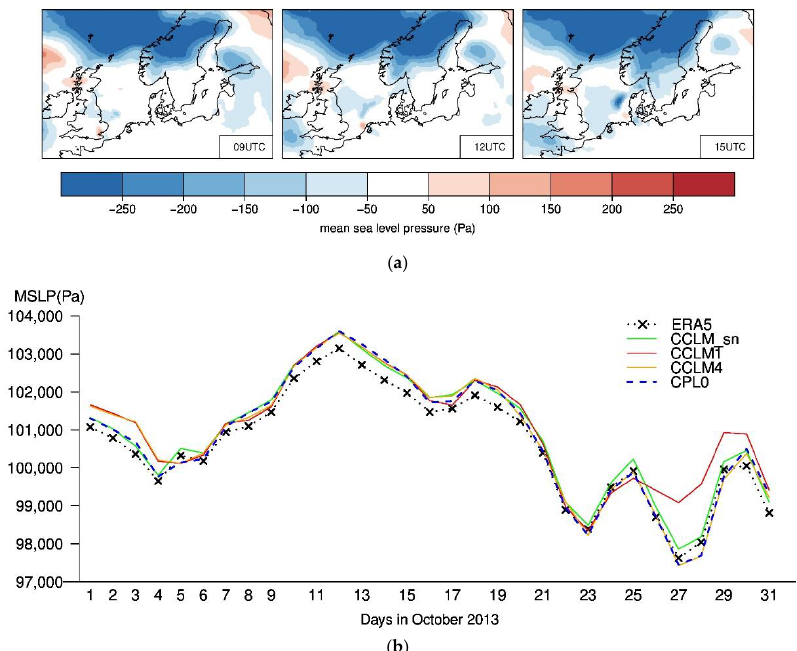
Figure 6. ( a ) Difference between IV of AHOI ensemble and the stand-alone CCLM ensemble for mean sea level pressure MSLP (Pa) at 09 UTC (left), 12 UTC (middle) and 15 UTC (right) on 28 October 2013. ( b ) Daily MSLP (Pa) averaged over the NwgSea area for 1–31 October 2013.